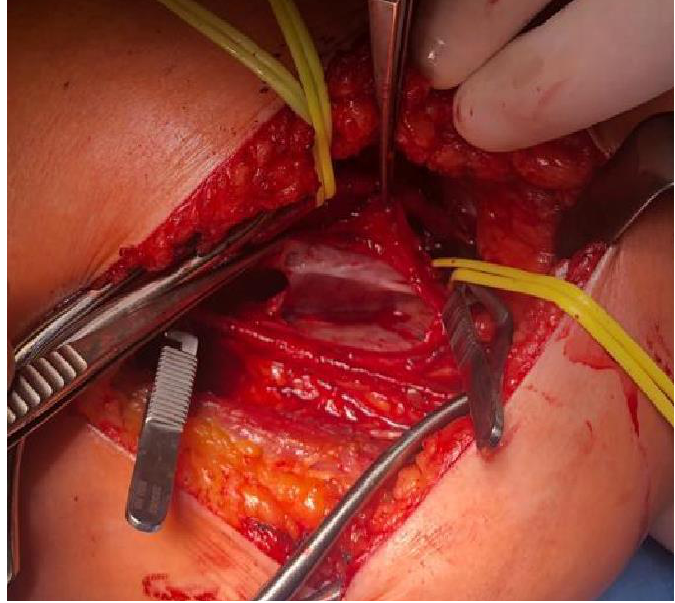
Figure 3. Intraoperative view after the isolation, incision and drainage of the popliteal vein aneurysm.